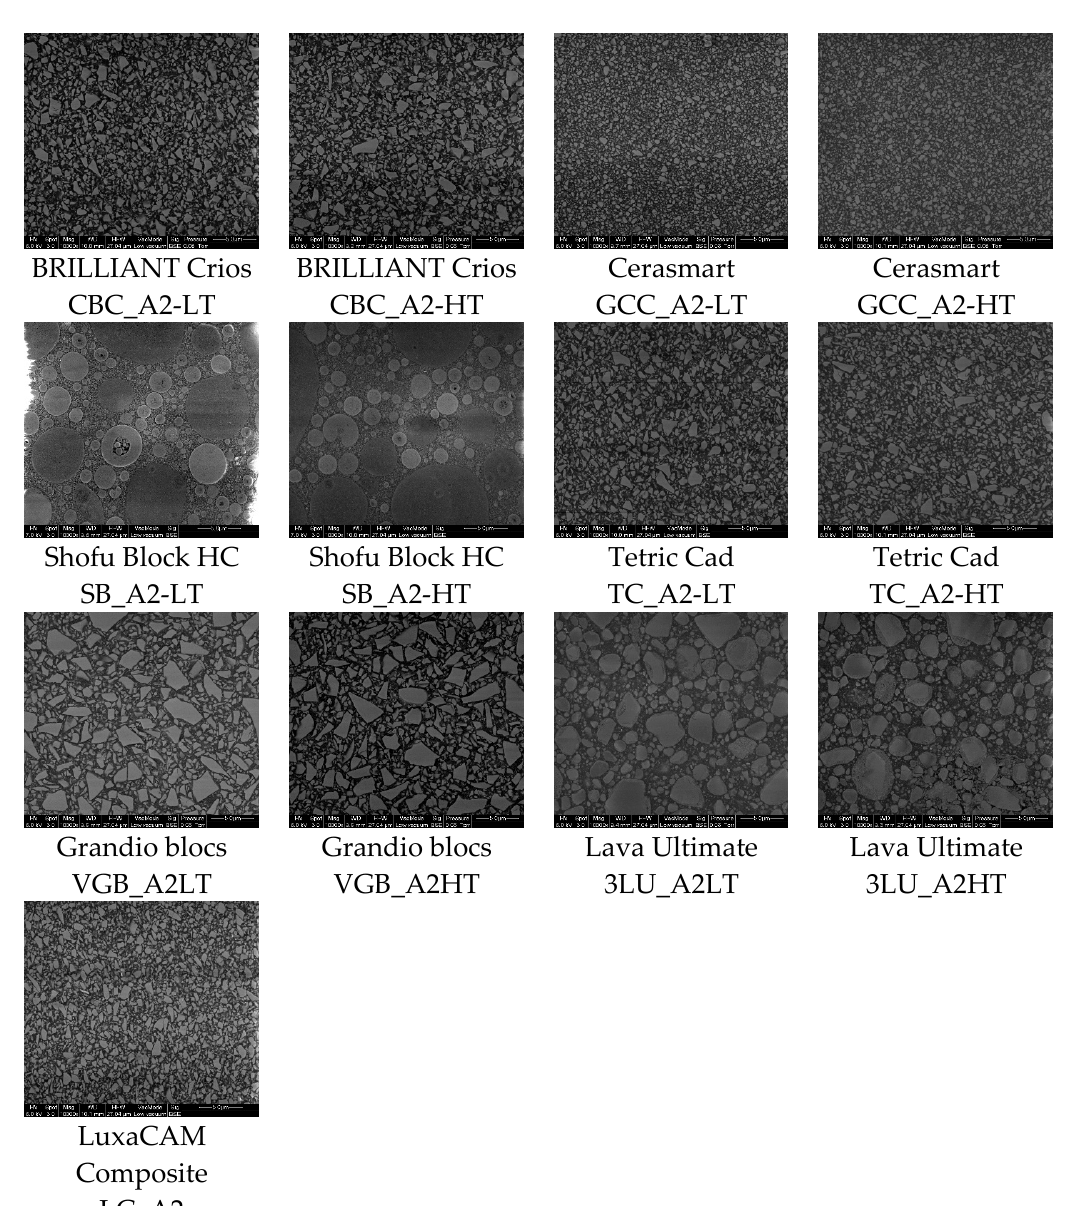
Figure 1. Scanning electron microscopy (SEM) images (25 × 23.5 µm 2 ) of cross sections of the various CAD/CAM RBCs with a constant magnification of 10,000 in BSE mode.